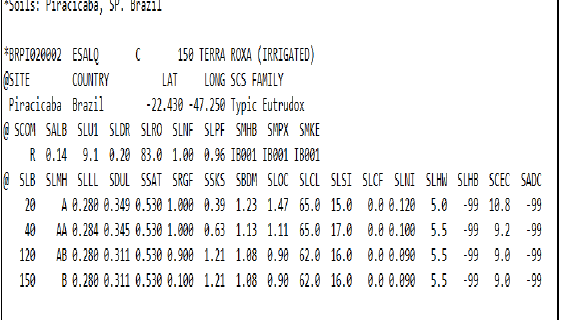
Figure 4. Soil data in DSSAT format